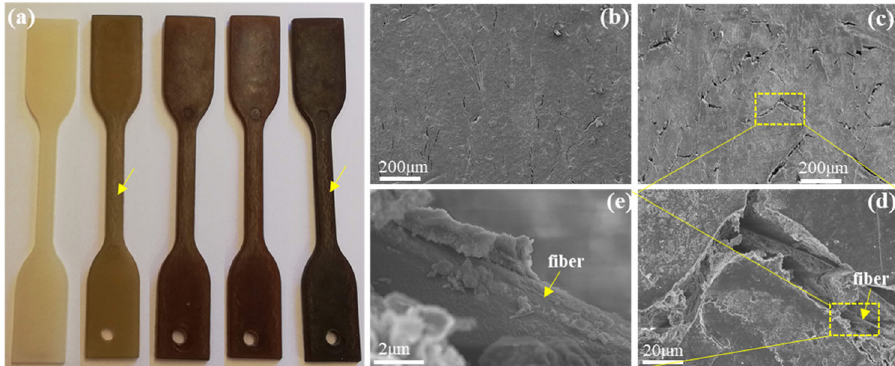
Fig. 5 Surface cracks on GF23-PA12 samples. a Images of GF23-PA12 samples (from left to right, samples with an ageing time of 0, 150, 300, 500 and 700 h) and SEM images of the surface of the GF23-PA12 samples aged for 150 h ( b ) and 700 h ( c – e ).